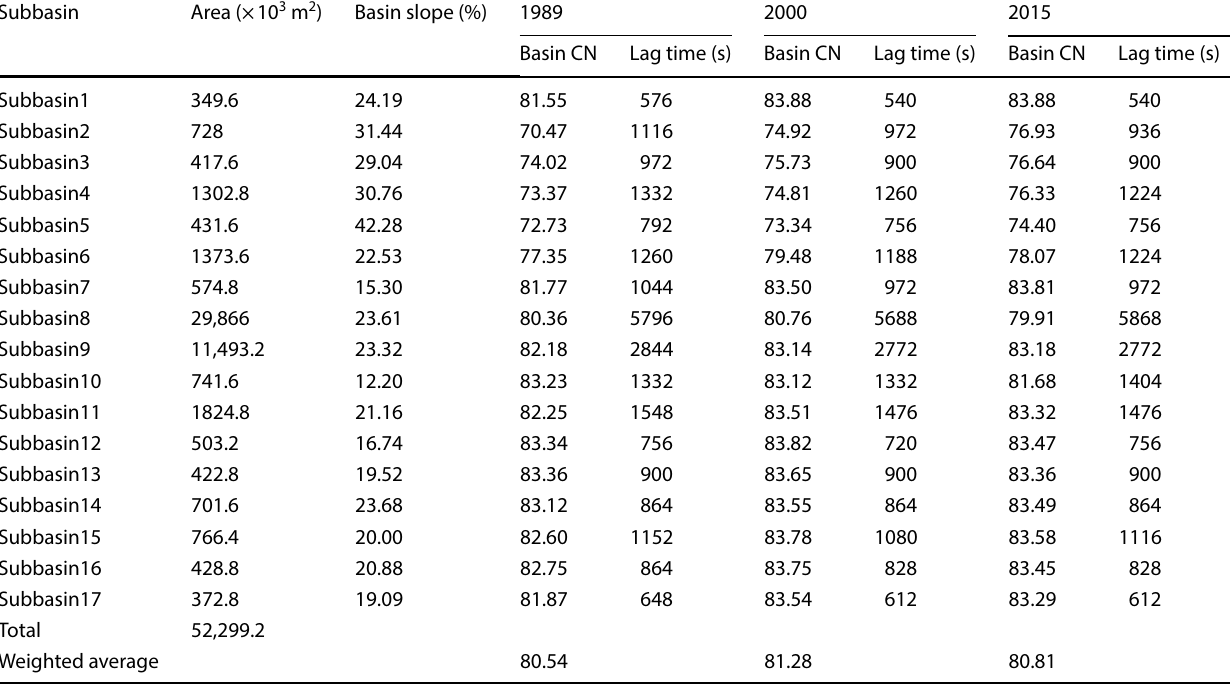
Table 7 Model parameters of Hayk Lake basin (1989, 2000, and 2015) Subbasin